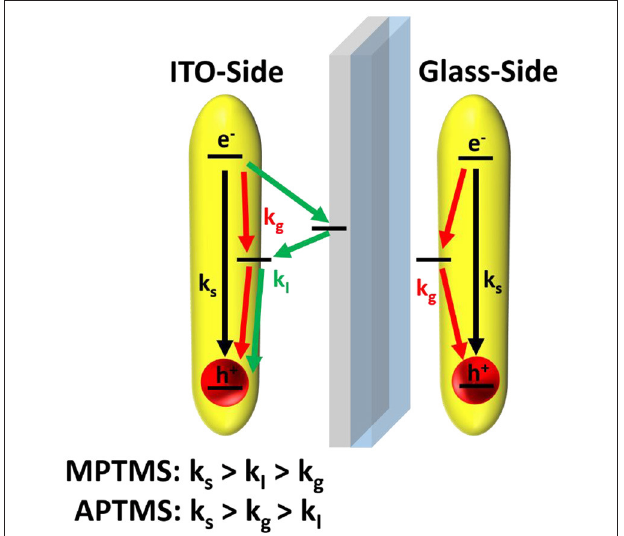
FIGURE 8 | A scheme of the described exciton quenching is based on three different mechanisms. The phenomenological kinetic constant k s describes all quenching mechanisms, which are existing in case of NRs in free solutions. The by linking molecules introduced trap state related quenching processes are described by the kinetic constant k g . Only excitons of NRs linked to the ITO side of the slide can undergo a quenching process, which is related to an interconnection between them and the free charge carriers of ITO (accounted for by the kinetic constant k I ).